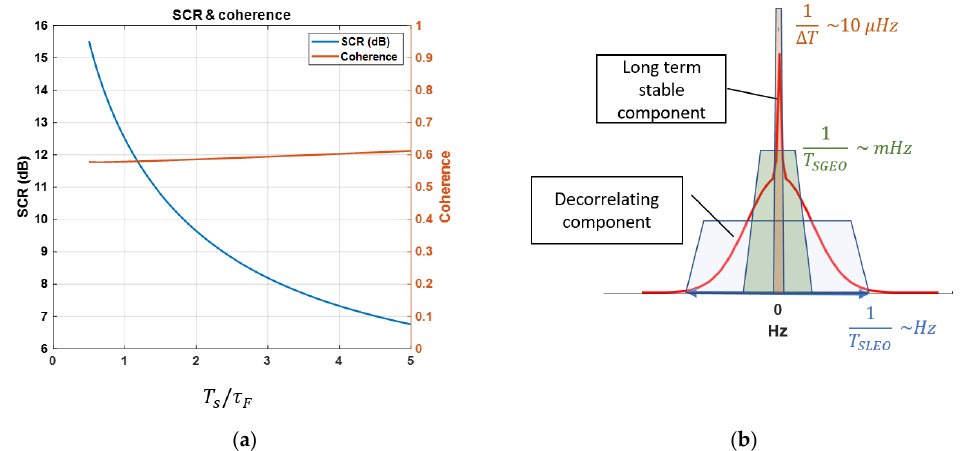
Figure 13. Expected coherence level as a function of the repeat pass interval, Δ T , normalized by the long decay time (horizontal axis), and of the integration time, normalized by the shift decay time (vertical axis). Figure 14. ( a ) Comparison between SCR and interferometric performances for the SoE decorrelation, as a function of the ratio between the focusing time and the fast decay time. Notice that coherence is mostly insensible to that. ( b ): Sketch of the scene power spectrum (red line), compared with the bandwidth of an LEO SAR (blue), a Geosynchronous Equatorial Orbit (GEO) SAR (green) and the one of the interferometric signal (orange), 1/Δ t .